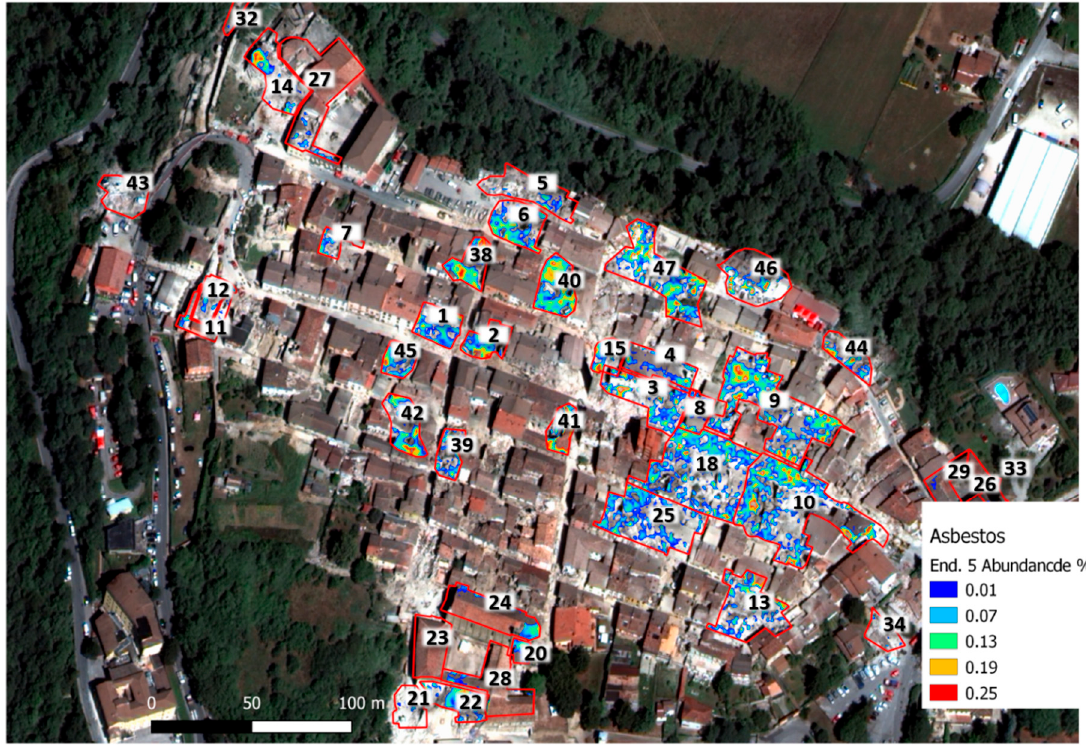
Figure 9. Asbestos distribution on rubble heaps with black labels and red borders. Background: pan-sharpened true colour.